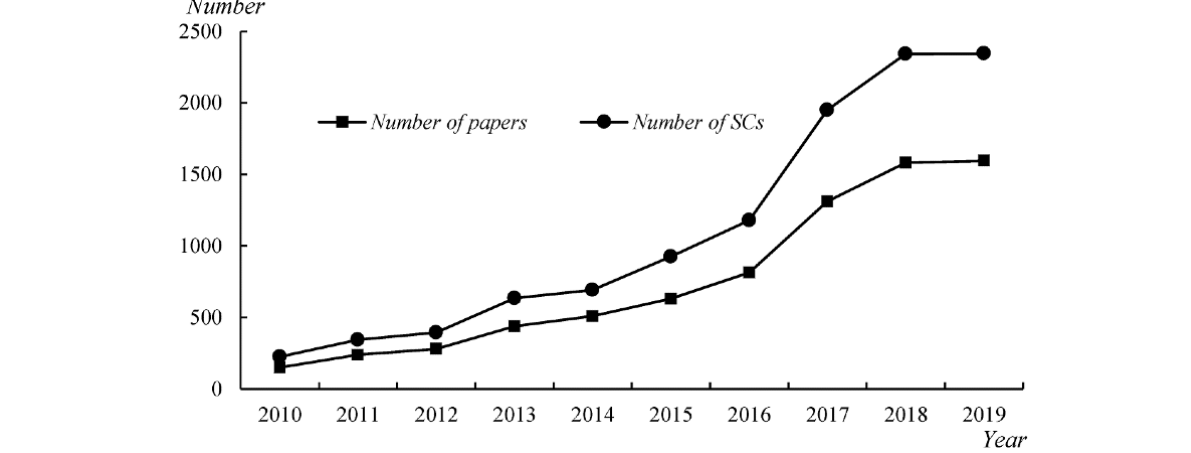
Figure 2. The basic statistics of precision–medicine related sample papers and subject categories from 2010 to 2019. SCs: subject